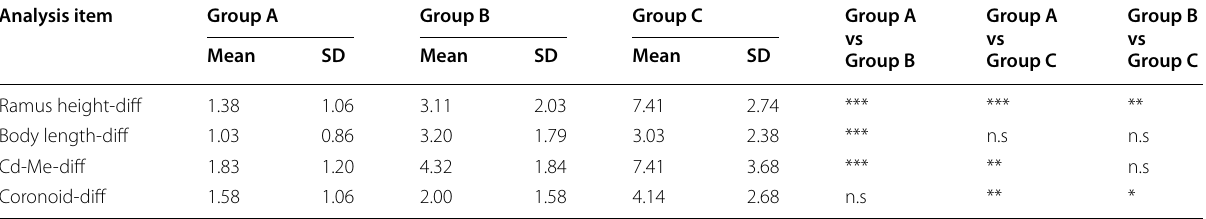
Table 1 Intergroup comparisons of analysis items based on mandibular morphology